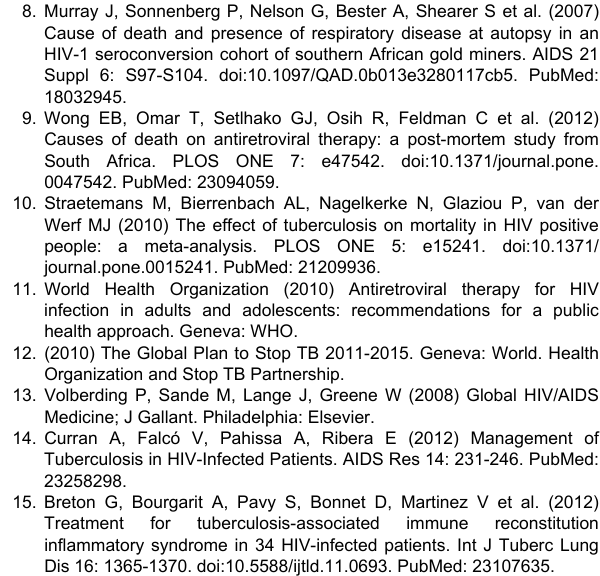
Table S5. Meta-regression results for the effect of TB treatment on